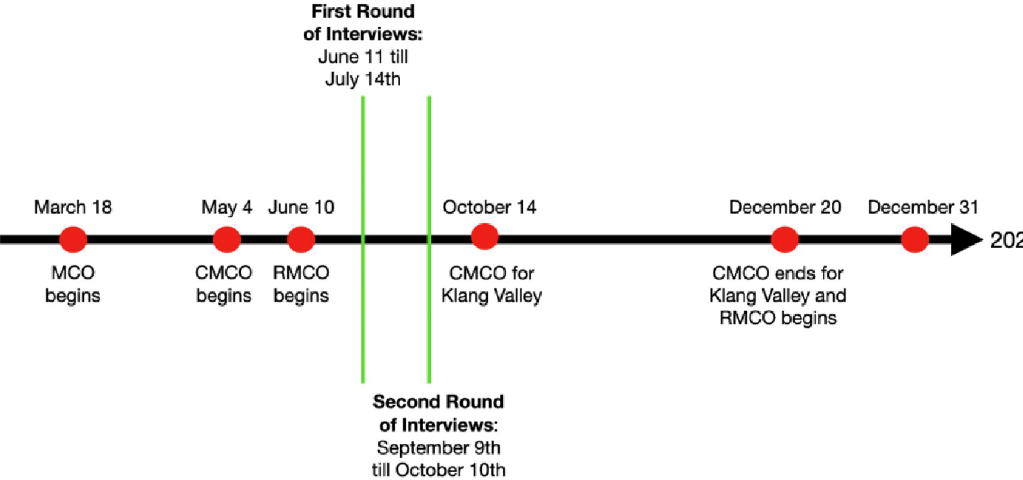
Fig 1. Timeline of interviews and the lockdowns (i.e. MCO, CMCO and RMCO).